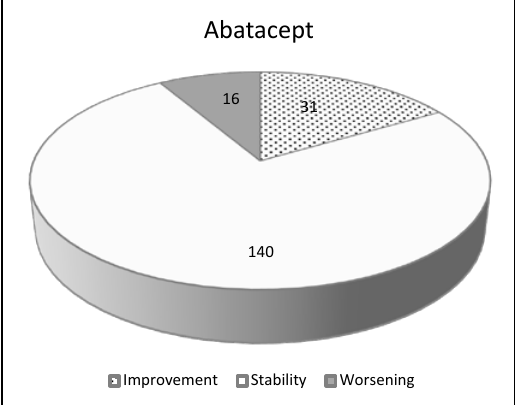
Figure 2. Pulmonary effects of abatacept in RA-ILD patients: a review of the literature.